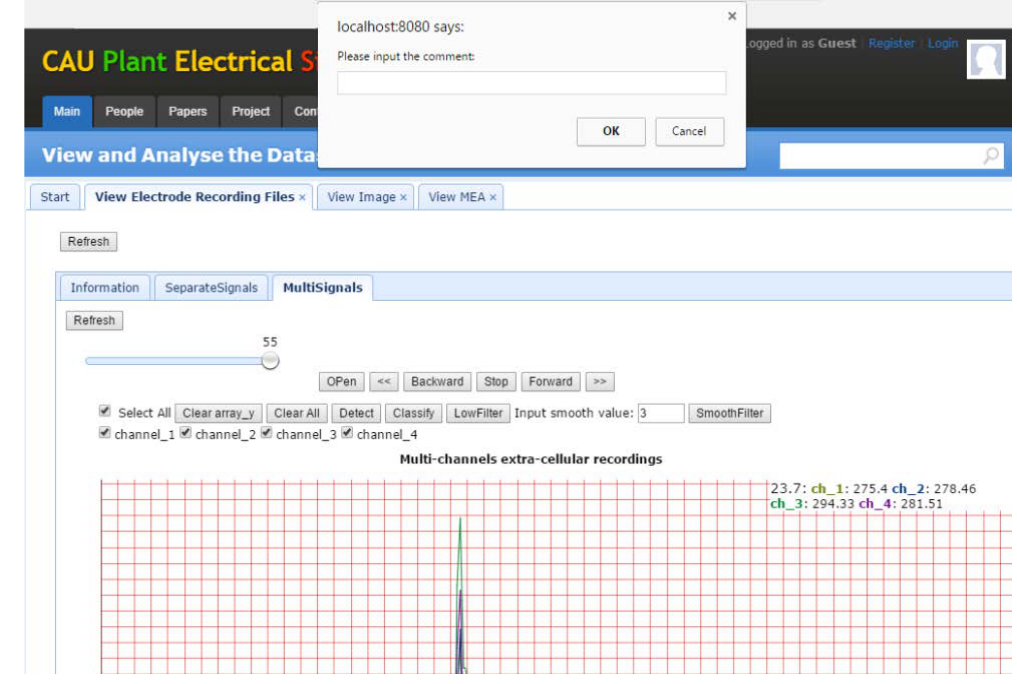
Figure 11. Add annotation for the plant electrical signals.